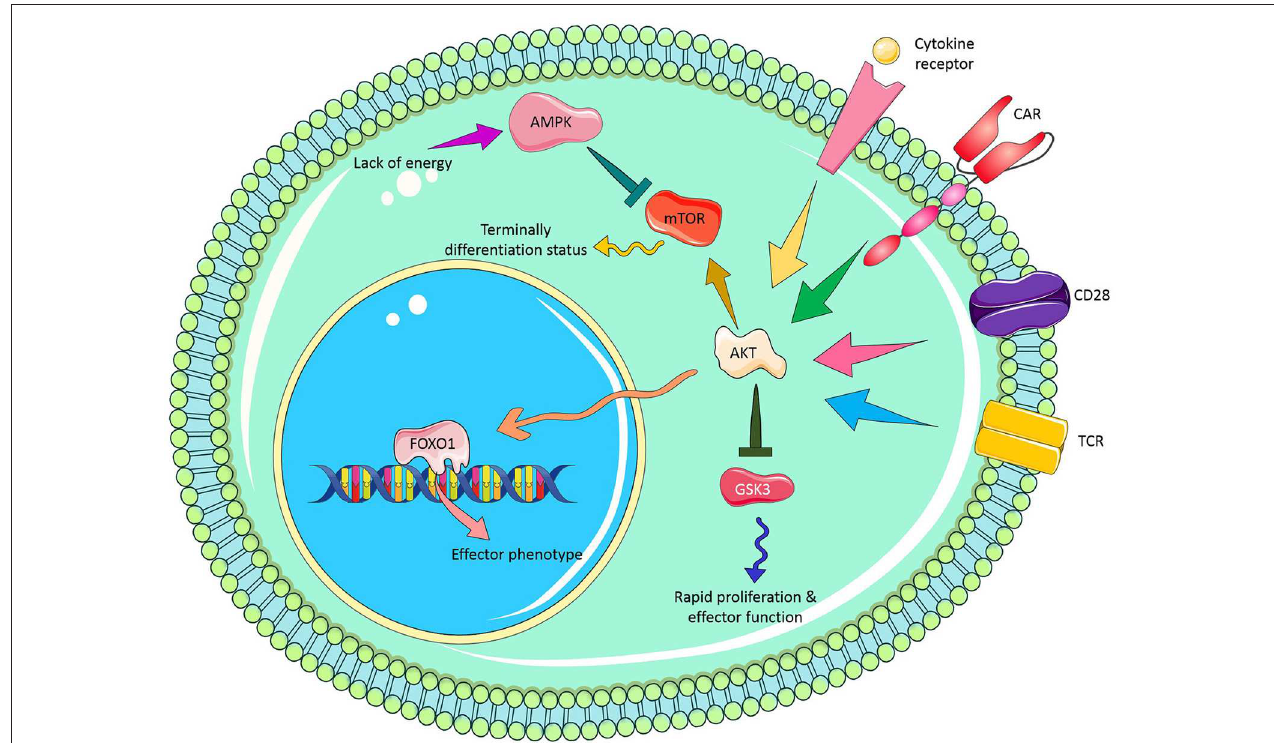
FIGURE 2 | Novel molecular signaling targets to improve CAR T cell